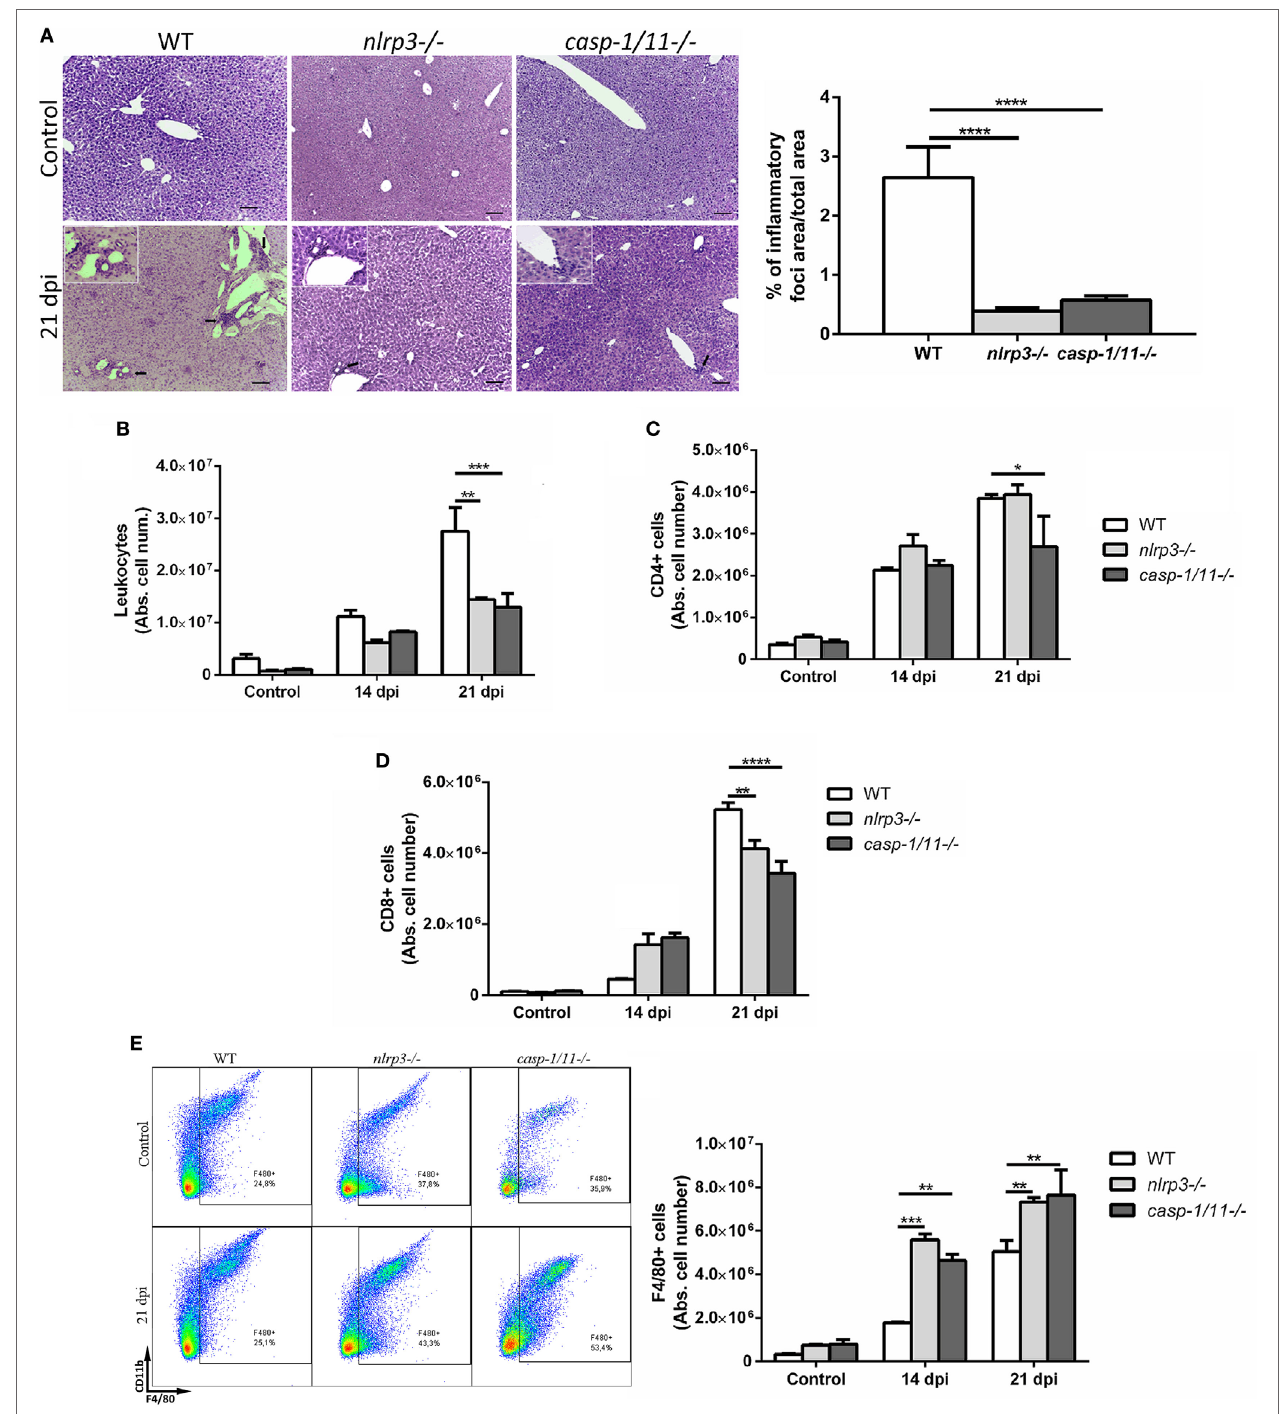
FigUre 2 | Infected caspase-1/11-deficient mice exhibit a marked reduction of hepatic CD8 + T cell number associated with increased number of macrophages. (a) Representative liver sections from uninfected control and Trypanosoma cruzi infected wild type (WT) and KO mice at 21 days post infection were stained with hematoxylin and eosin. Micrographs are shown at 100 × and bar scales depict 50 µm. Insets are magnifications of inflammatory infiltrates. Bars depict percentages of inflammatory foci. (B) Absolute number of hepatic leukocytes from WT, nlrp3 − / − , and caspase-1/11 − / − mice determined by flow cytometry. (c) Absolute number of purified hepatic CD4 + and (D) CD8 + T cells. (e) Representative dot plots and absolute cell number of F4/80 + CD11b + and F4/80 + CD11b − leukocytes. Gate strategy is depicted in Figure S1 in Supplementary Material. Data are shown as mean ± SEM from one of three representative experiments; n = 3–6 mice per group. Statistical significance was evaluated by two-way ANOVA followed by Bonferroni post hoc test. * p < 0.05; ** p < 0.01; *** p < 0.001.